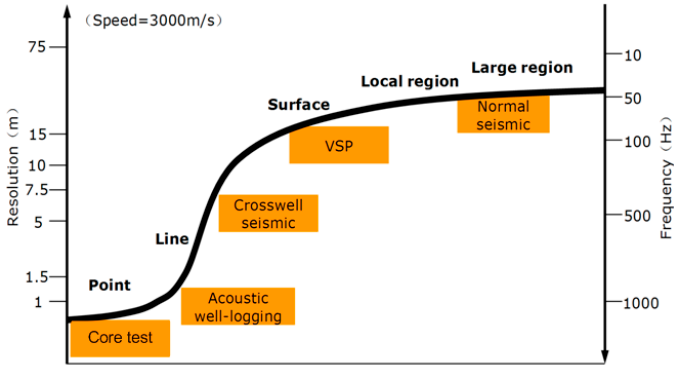
Figure 1. Frequency band range and longitudinal resolution of multi scale geophysical data [100–102].